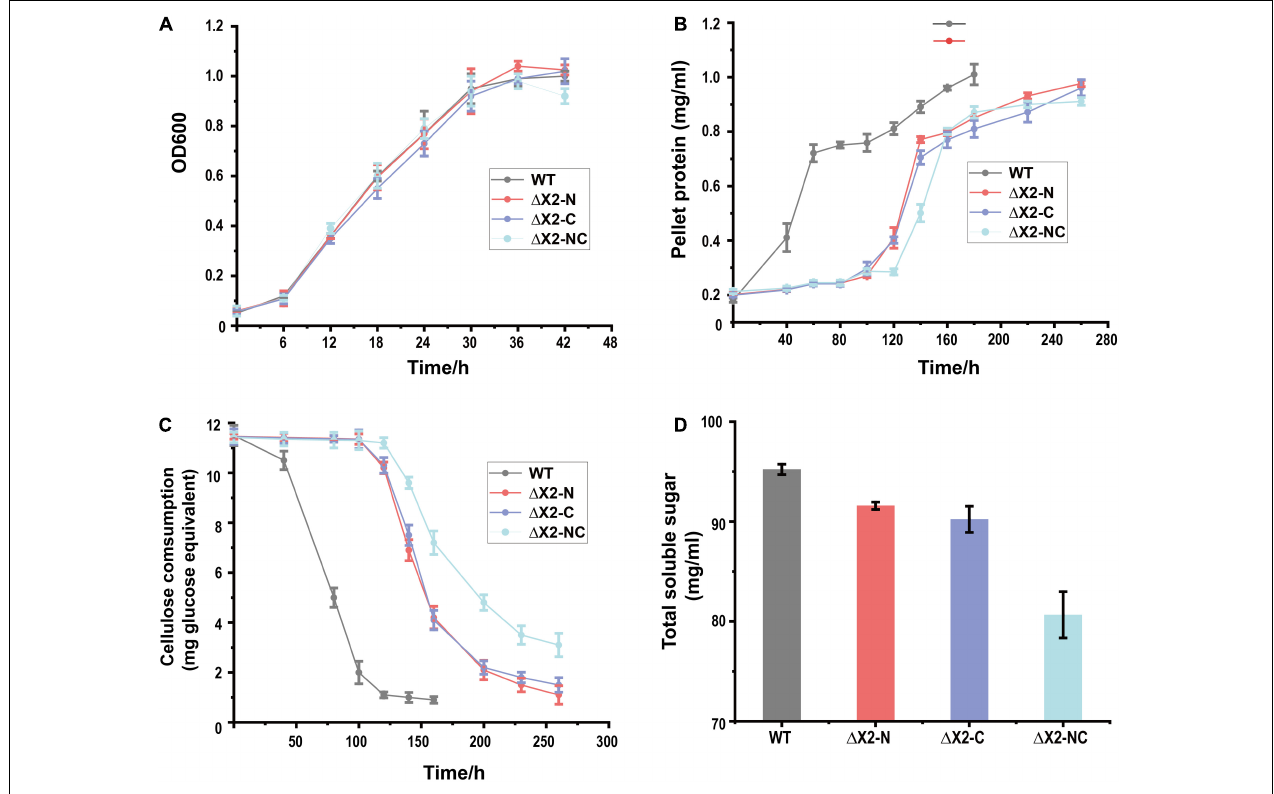
FIGURE 3 | Disruption of X2 modules increased the lag phase and decreased the cellulose degradation efficiency when mutants were grown on cellulose. (A) Growth profiles of WT, (cid:49) X2-N, (cid:49) X2-C, and (cid:49) X2-NC grown on cellobiose. (B) Growth profiles of WT, (cid:49) X2-N, (cid:49) X2-C, and (cid:49) X2-NC grown on cellulose. (C) Cellulose degradation profiles of WT, (cid:49) X2-N, (cid:49) X2-C, and (cid:49) X2-NC. (D) Released total soluble sugars in supernatant of medium at final time point for each strain when grown on cellulose. Data are presented as the mean of three biological replicates and error bars represent standard deviation